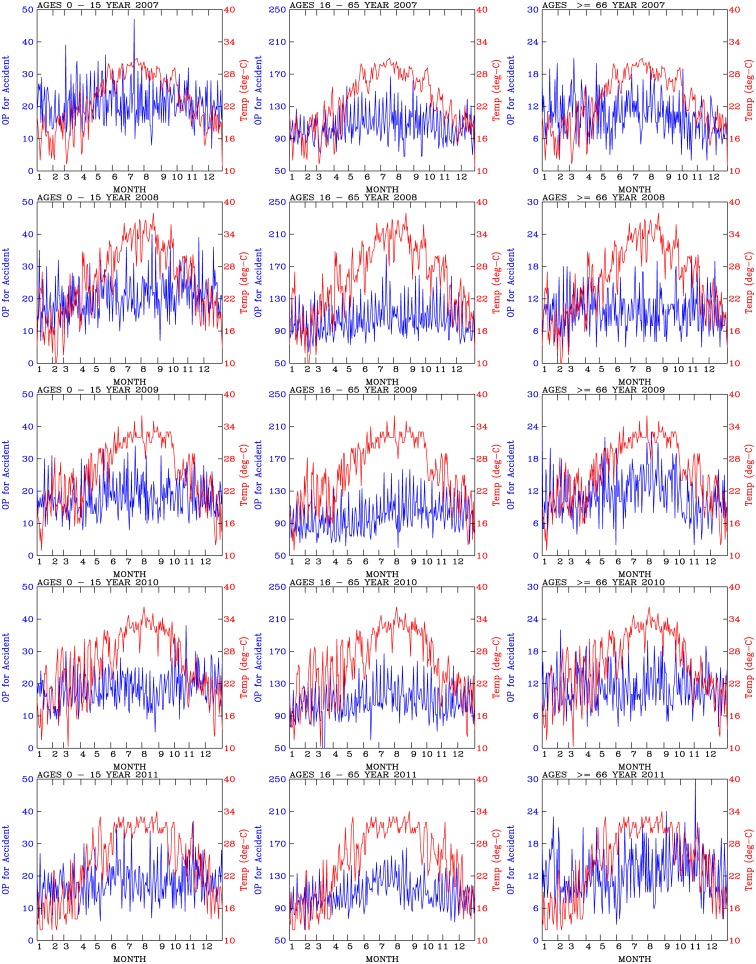
Time-series plots of the daily number of outpatients for accidents (blue curves; see the left y-axis for the scale) and temperatures (red curves; see the right y-axis for the scale).